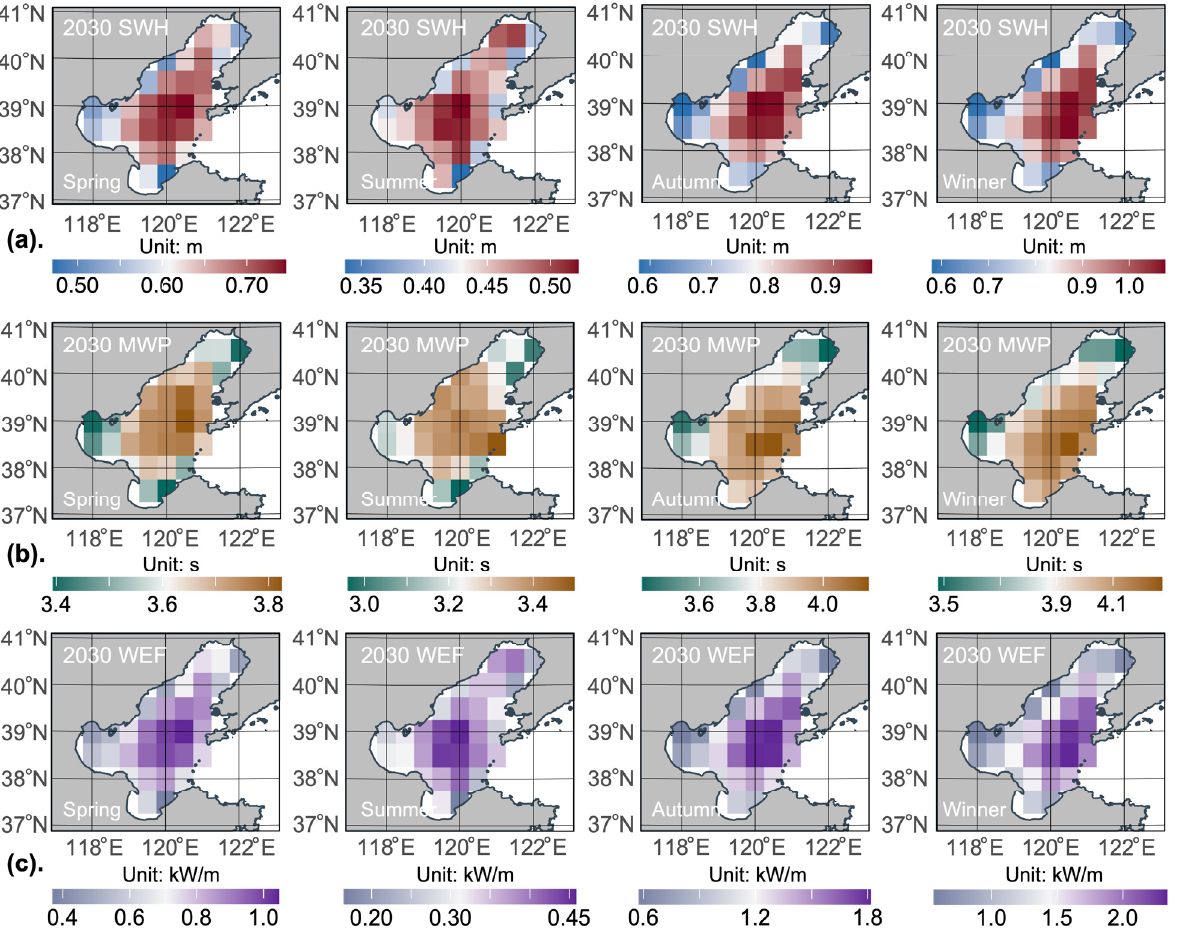
Figure 8. Seasonality of significant wave height ( a ), mean wave period ( b ), and wave energy flux ( c ) in the Bohai Sea in 2030, from left to right, in spring, summer, autumn, and winter.